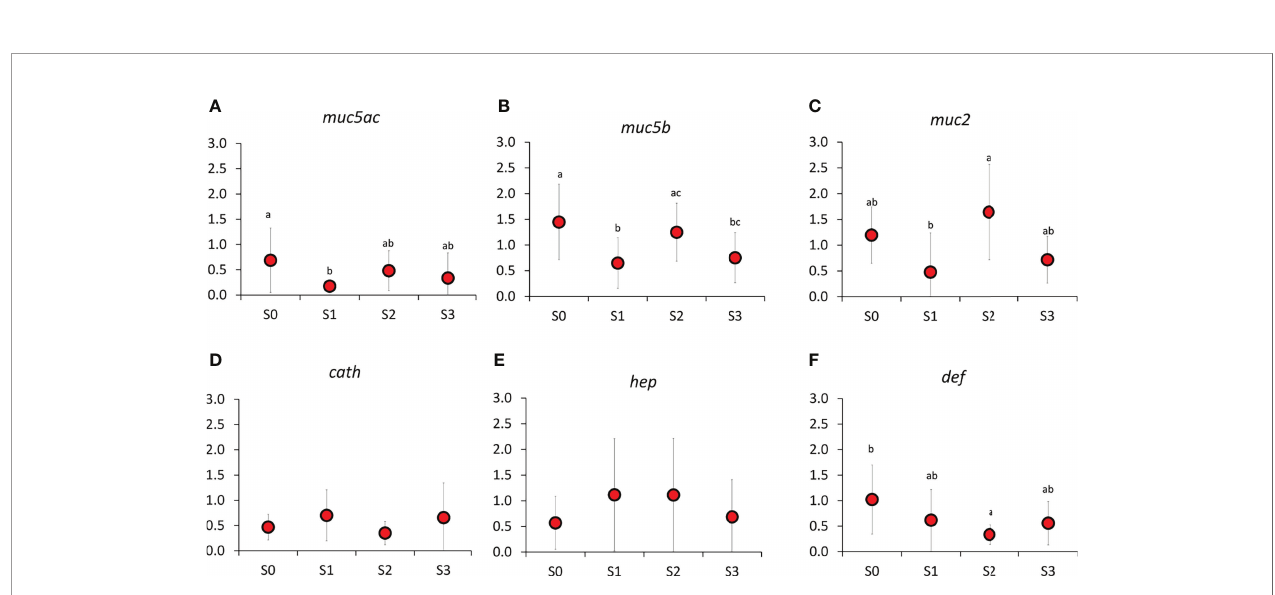
FIGURE 8 | Expression of key genes important for (A – C) mucin and (E, F) antibacterial defence in the skin. Different letters indicate a signi fi cant difference at P < 0.05, analyzed by ANOVA followed by a Holm – Sidak post-hoc test. Values are presented as mean ± SD of 15 individual fi sh (N=15) per sampling